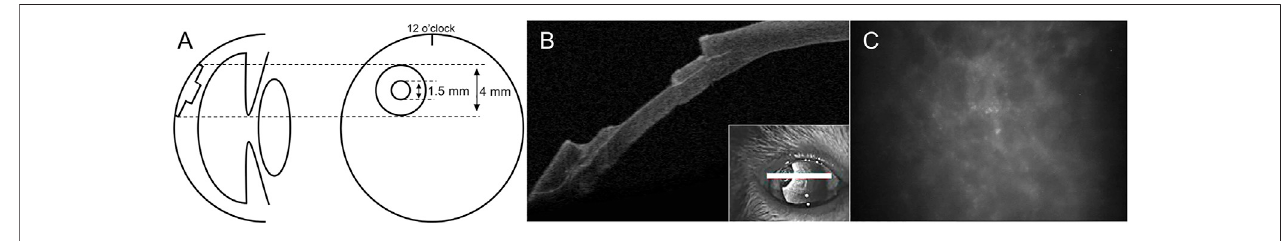
FIGURE 1 | Surgical model. Schematic illustration (A) and optical coherence tomography imaging (B) of the stepwise ablation pro fi le. Confocal microscopy (C) of an acellular gelled LiQD cornea matrix sample 30 min after its delivery from the